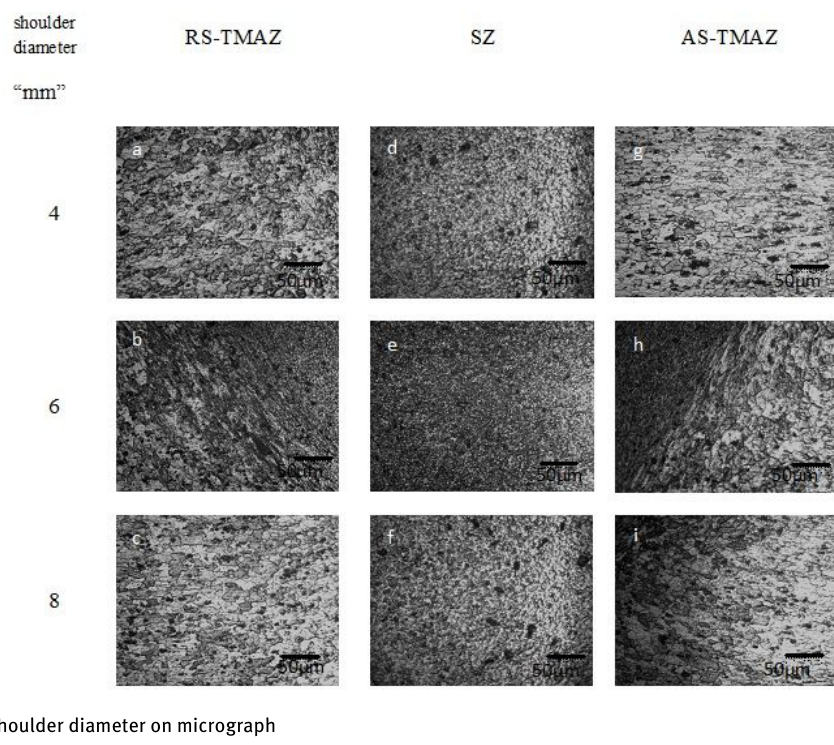
Figure 18: Effect of shoulder diameter on micrograph